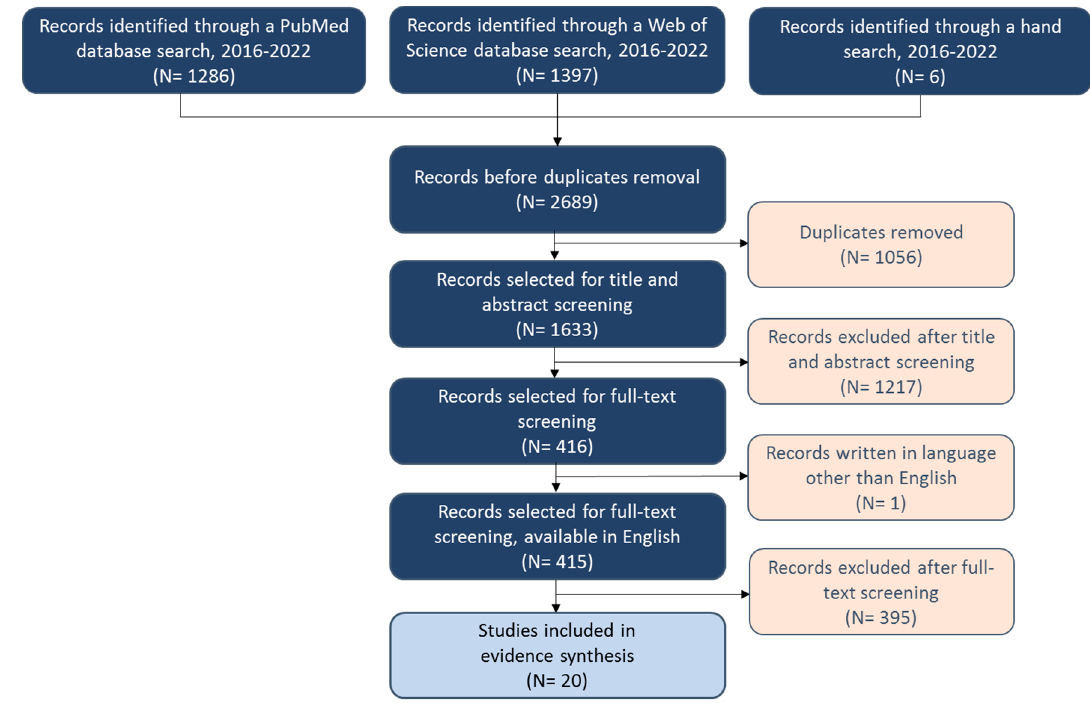
Figure 1. PRISMA flow diagram. Table 3. Characteristics of included